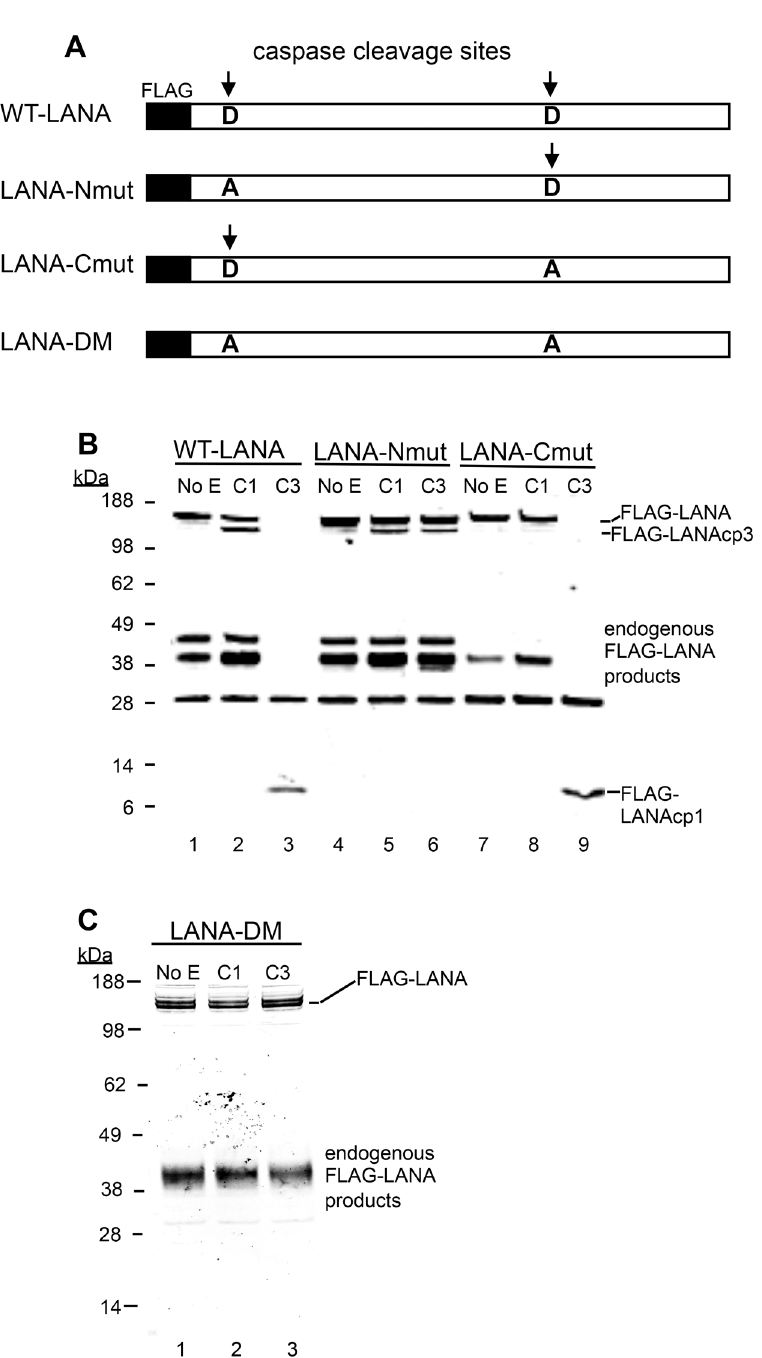
Fig 3. Mutation of putative LANA caspase cleavage sites at the N- and C-termini of LANA prevent caspase cleavage of LANA. (A) A schematic diagram showing the FLAG-WT-LANA (WT-LANA) and the location of two caspase cleavage sites identified through sequence and peptide analysis. FLAG is present at the N-terminus of LANA in these constructs and the aspartate cleavage sites susceptible to caspase cleavage are indicated with an arrow. Three mutant forms of FLAG LANA were prepared. FLAG-LANA-Nmut (LANA-Nmut) contains an Asp to Ala (A- > D) mutation at the N-terminal site, FLAG-LANA-Cmut (LANA-Cmut) contains an A- > D mutation at the C-terminal site and FLAG-LANA-DM (LANA-DM) has both sites mutated from A- > D. (B) HEK293T cells were transiently transfected with expression vectors producing FLAG-tagged forms of WT-LANA, LANA-Nmut or LANA-Cmut (labeled as in 3A). Following transfection, nuclear extracts were harvested and treated for 16 hrs at 37°C with PBS (control), caspase-1 (C1) or caspase-3 (C3)